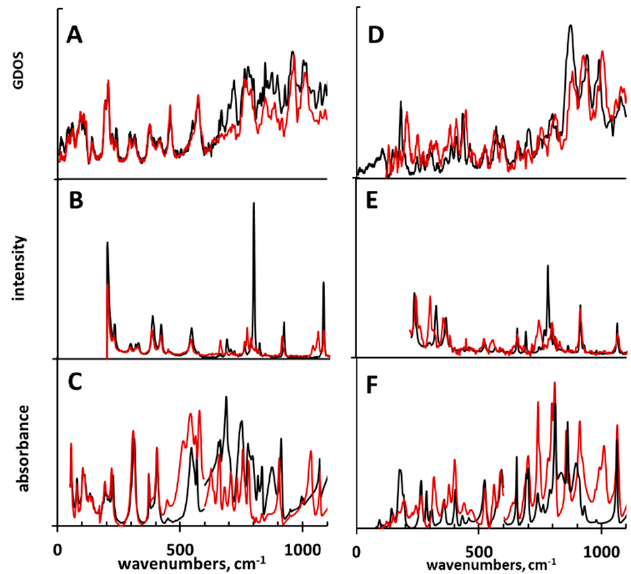
Figure 11. Normalized IINS ( A and D ), Raman ( B and E ), and IR ( C and F ) spectra of compounds 3 ( A — C , black spectra) and 4 ( D – F , black spectra) and their deuterated derivatives (red spectra).